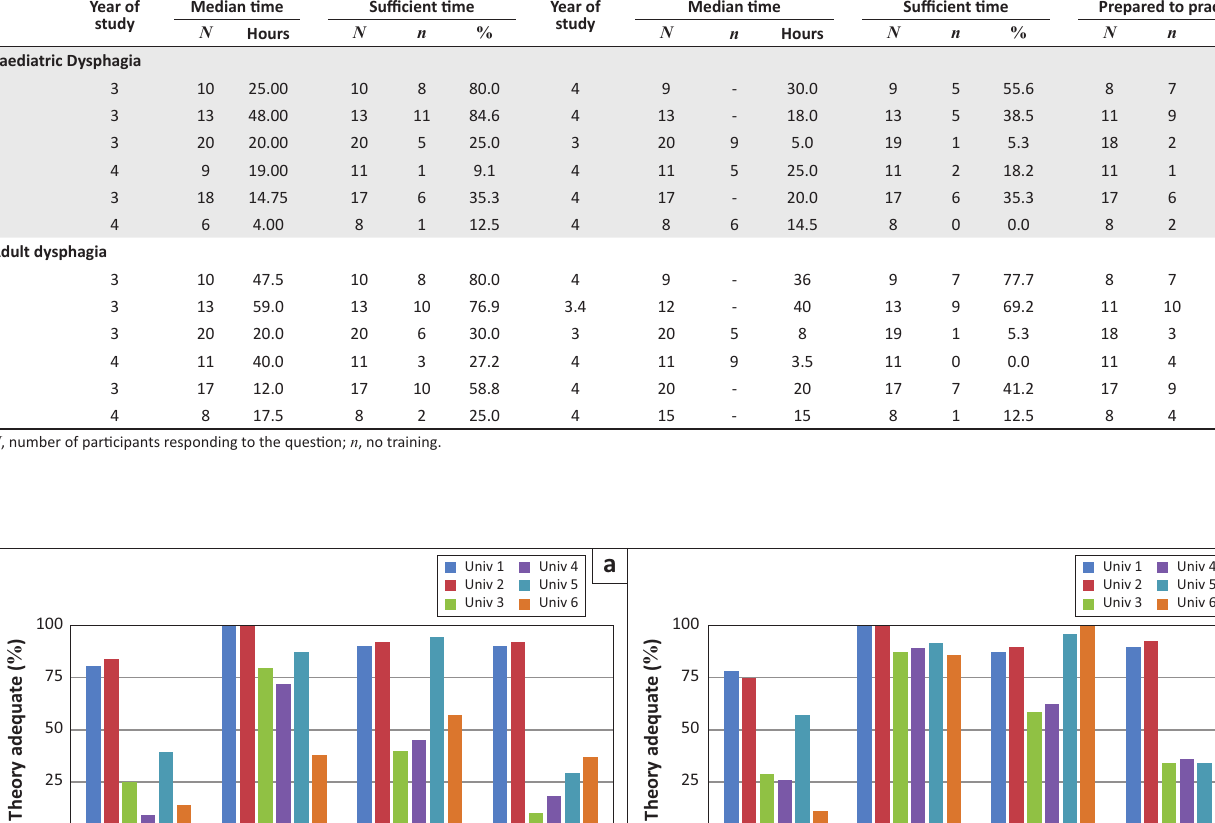
TABLE 2: Perceptions of dysphagia curricula time and preparedness to practise. University